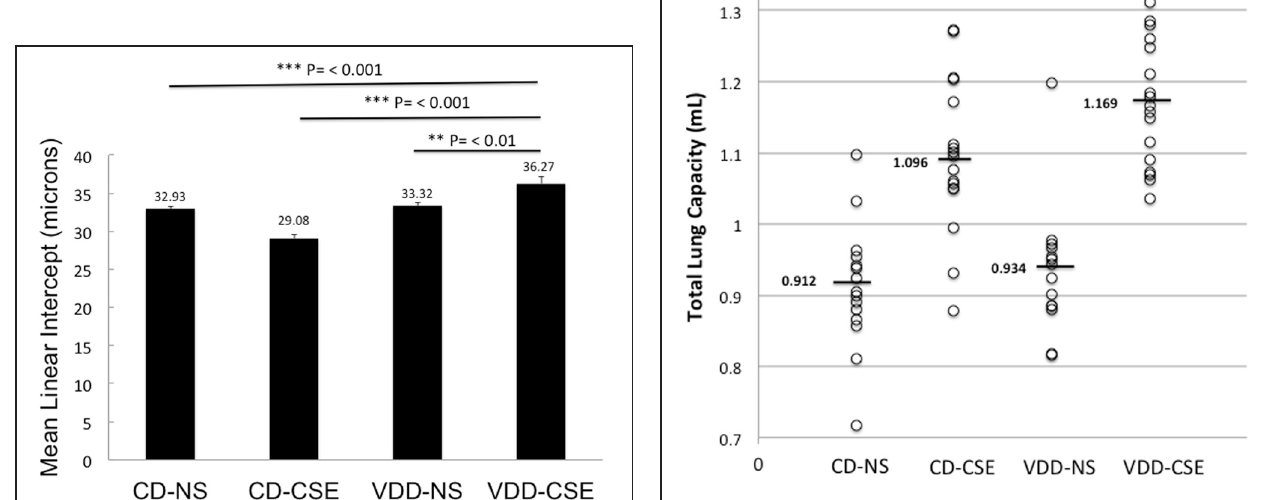
FIGURE 3 | Mean Linear Intercept ( L M ) in experimental groups. Levels shown reflect means ± SEM. L M is significantly longer in VDD-CSE mice compared to all other treatment groups and is consistent with emphysema. Data shown are based on analyses of 10 images from each lung section of each of eleven mice in each of the four treatment groups (440 total images analyzed).